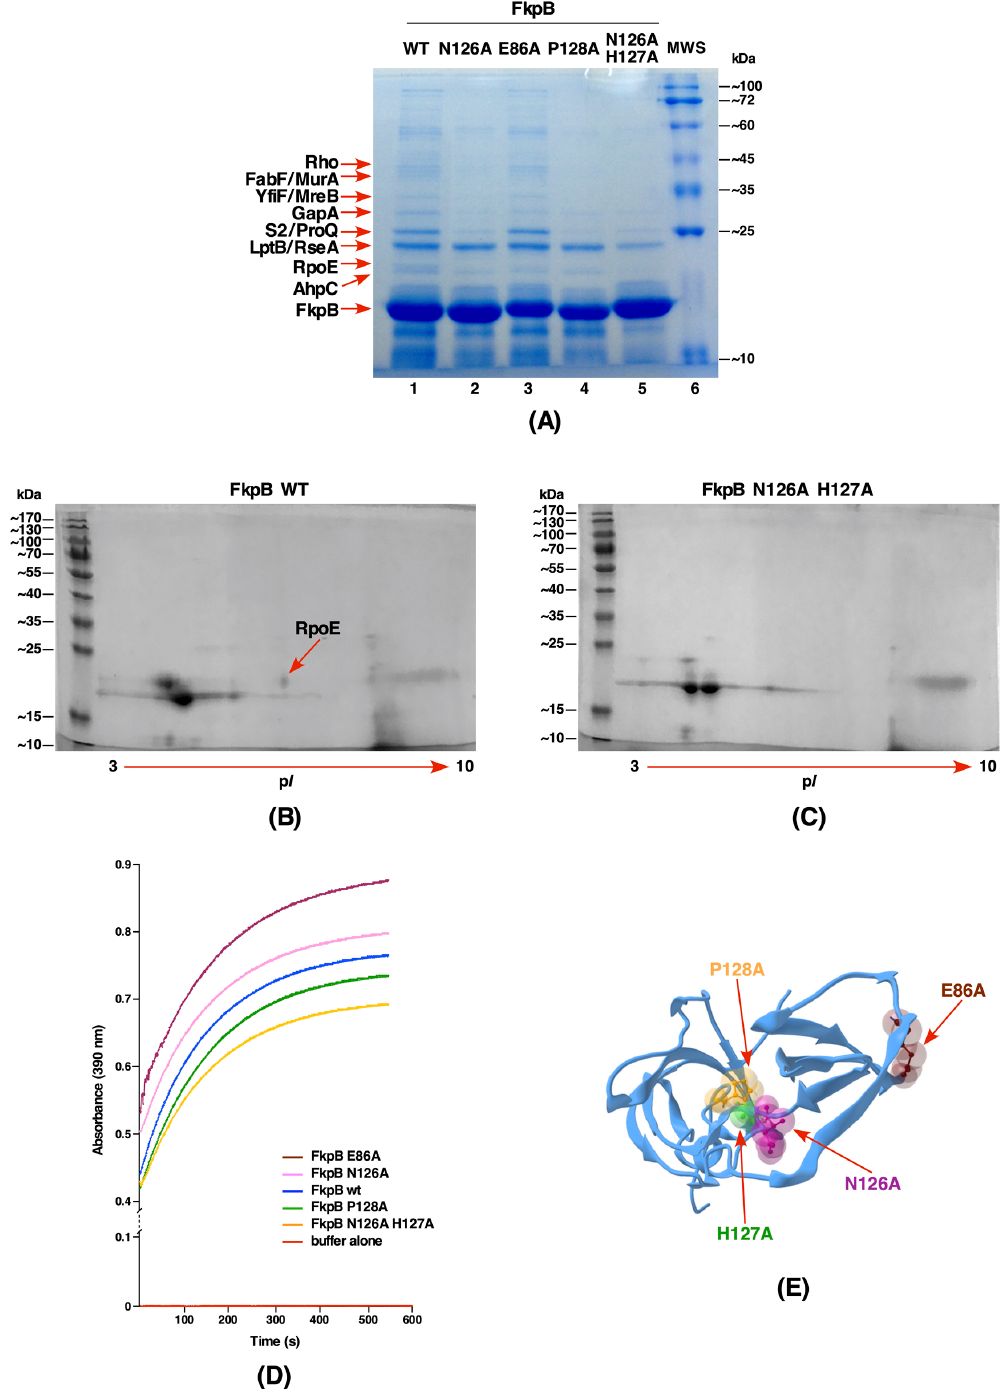
Figure 5. The RpoE sigma factor is one of the substrates of FkpB. ( A ) Co ‐ purification profile of the wild ‐ type FkpB protein and its derivatives N126A, P128A, E86A and with N126A H127 double mutation after the induction in a ∆ 6 ppi derivative with 100 µ M IPTG. Proteins were resolved on a 12.5% SDS ‐ PAGE and co ‐ eluting proteins are indicated and their identity shown. ( B ) Picture of dried 2 ‐ D gels of purified FkpB and co ‐ eluting RpoE. The identity of the spot corresponding to RpoE was obtained from MALDI ‐ TOF and is indicated. ( C ) 2 ‐ D gel of purified FkpB variant N126A H127. ( D ) The PPIase activity in the chymotrypsin ‐ coupled assay with 0.5 µ M purified of above mentioned FkpB variants in comparison to the wild type is plotted. ( E ) Position of various FkpB residues, which were mutated, is indicated in the structure of FkpB (PDB 4DT4).